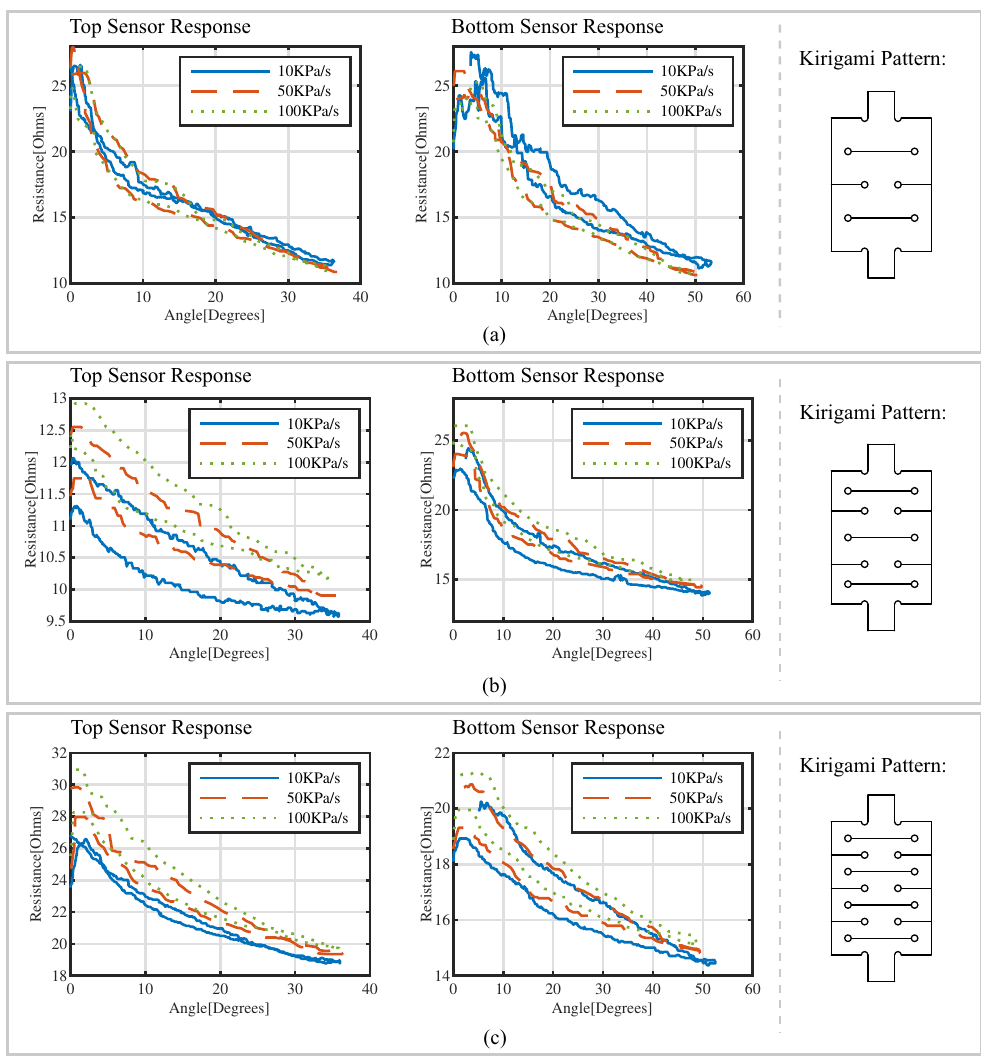
Figure 10. Resistance responses of sensors with ( a ) two-unit kirigami cutting patterns, ( b ) three-unit kirigami cutting patterns and ( c ) four-unit kirigami cutting patterns with respect to bending angles; 10 kPa/s (solid lines), 50 kPa/s (dashed lines) and 100 kPa/s (dotted lines). Table 2. Performance of the calibration neural network (all-to-one mode). RMSE